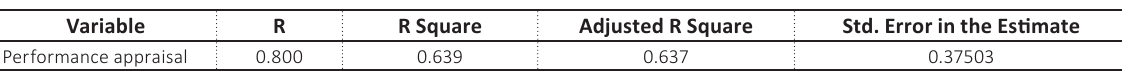
Table 13. Model summary for